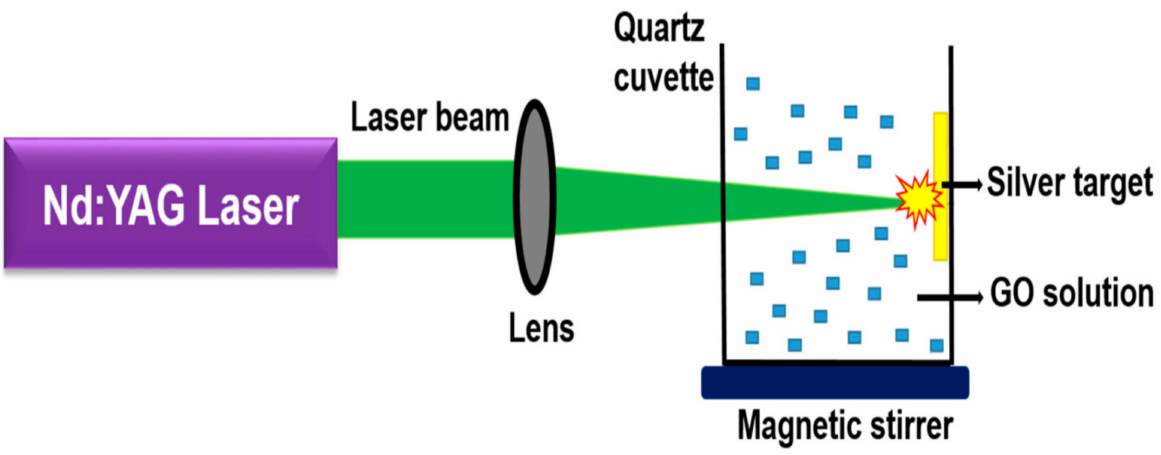
Figure 6. Schematic representation of the laser ablation method for graphene synthesis [Reprinted with permission from ref. [56] Nancy, P.; Jose, J.; Joy, N.; Valluvadasan, S.; Philip, R.; Antoine, R.; Thomas, S.; Kalarikkal, N. Fabrication of Silver-Decorated Graphene Oxide Nano-hybrids via Pulsed Laser Ablation with Excellent Antimicrobial and Optical Limiting Performance. Nanomaterials 2021 , 11 , 880. https://doi.org/10.3390/nano11040880, Copyright ©